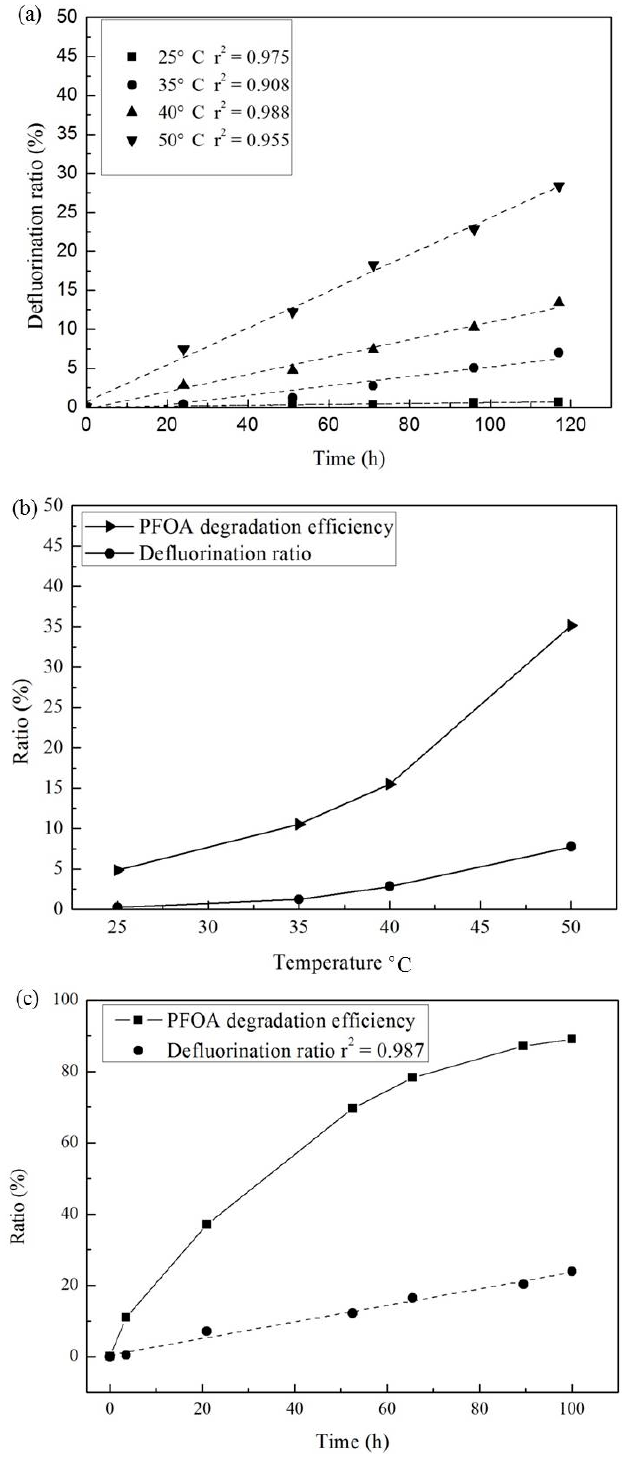
Figure 3. Effect of temperature and reaction time on PFOA degradation: ( a ) effect of reaction time on PFOA DF ratio at different temperature ([PFOA] 0 = 20 μ M; the molar ratio of PFOA to persulfate = 1:100; temperature = 25 °C, 35 °C, 40 °C, 50 °C; pH adjusted by H 2 SO 4 to 2.0); and ( b ) effect of temperature on PFOA degradation efficiency and DF ratio ([PFOA] 0 = 20 μ M; molar ratio of PFOA to persulfate = 1:100; reaction time = 24 h; pH adjusted by H 2 SO 4 to 2.0); and ( c ) effect of reaction time on PFOA degradation efficiency and DF ratio ([PFOA] 0 = 20 μ M; molar ratio of PFOA to persulfate = 1:100; temperature = 50 °C; pH adjusted by H 2 SO 4 to 2.0).